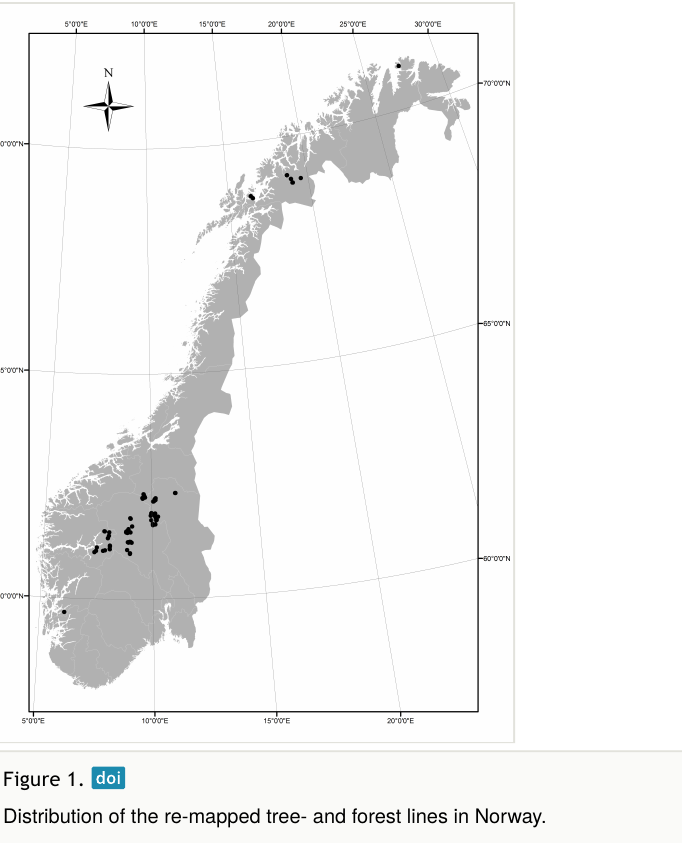
Figure 1. Distribution of the re-mapped tree- and forest lines in